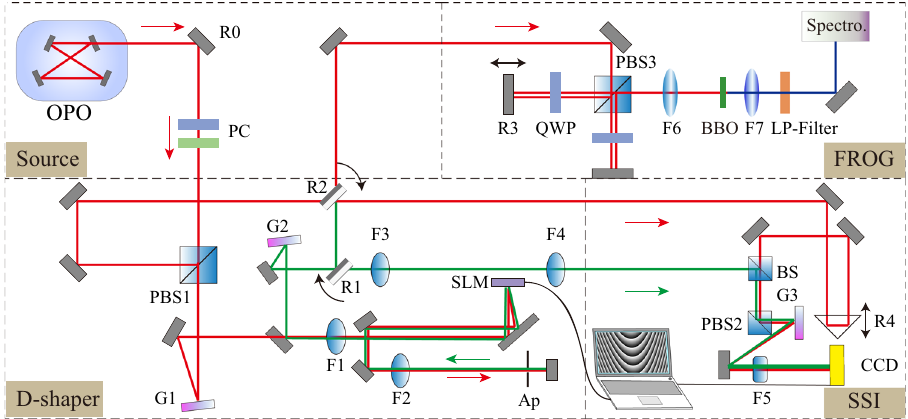
Fig. 5| Experimentalsetup forrealizationsoffractionalSchrödingerequation, withconstituents “ Source ” , “ D-shaper ” , “ FROG ” ,and “ SSI ” ,respectively. Labels are de fi nedasfollows. BS: abeamsplitter;PBS1-3: polarization beams splitters;R0: a highly-re fl ective mirror at 800nm; R1-2: fl ip (90 ∘ ) mirrors; R3-4:movable mirrors fi xed on the translation stage; G1-3: optical gratings with grating densities 1200, 1200,and600permm,respectively;F1-4:convexlenseswiththefocuslength400, 400, 400, and 300mm, respectively; F5: a cylinder lens with the focus length